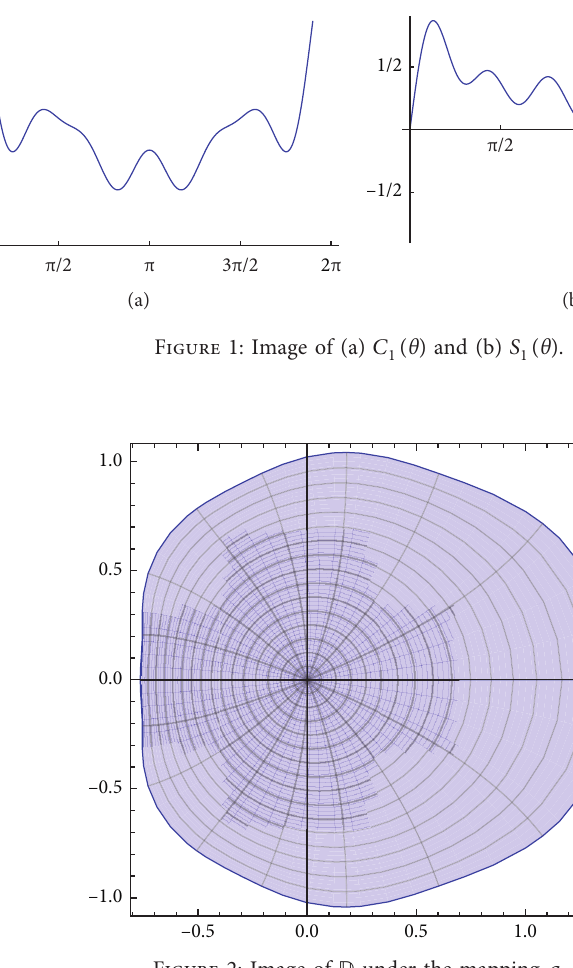
Figure 2: Image of D under the mapping g